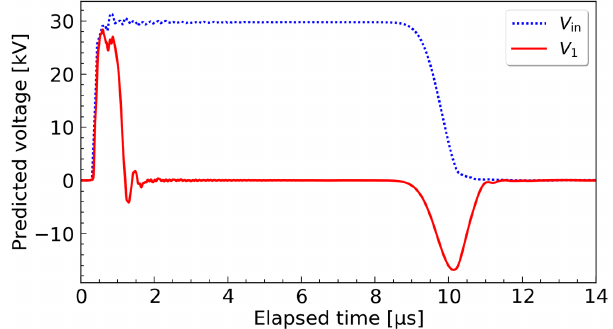
FIG. 5. Voltage at the input of the kicker magnet ( V voltage of screen conductor adjacent to HV busbar ( V 1 ) for 60 kV PFN voltage [30].